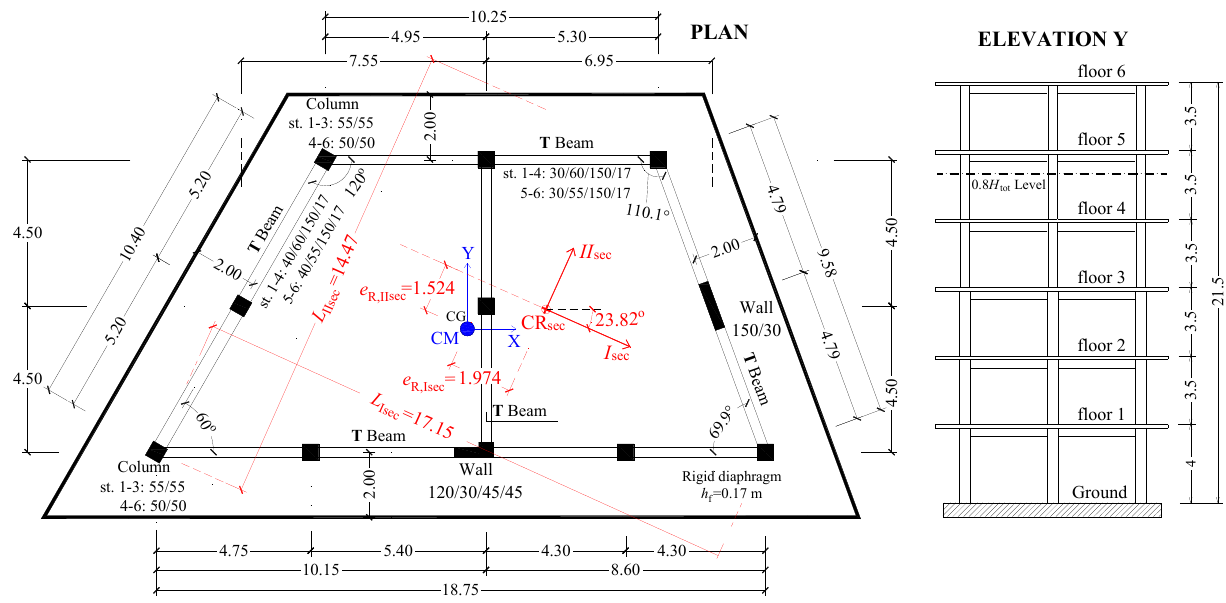
Figure 6. Plan and elevation view of the six-story RC building. “Capable Near Collapse Principal System, III sec ( CR sec ) , I sec , II sec ” defined in the nonlinear model ( EI sec ) of the